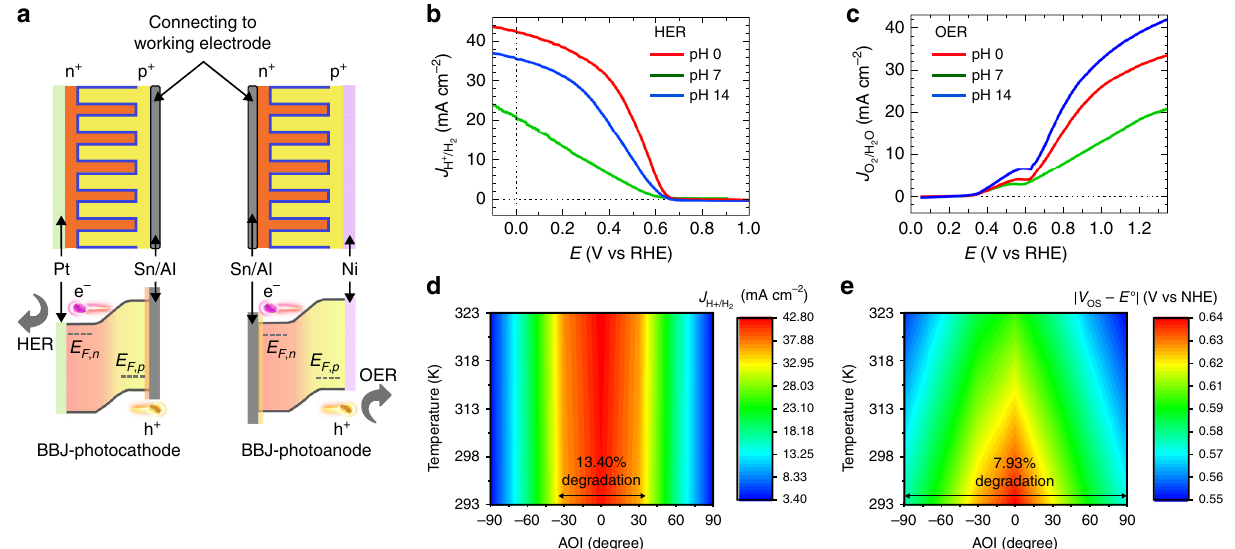
Fig. 2 Photoelectrochemical characteristics of a unit BBJ cell. a The schematic and band pro fi le of the BBJ – PEC cells. LSV curves under simulated AM 1.5 G illumination in acidic (red line), neutral (green line), and basic (blue line) electrolytes measured by a BBJ unit cell for b HER and c OER. The AOI and temperature dependent PEC characteristics of d J H þ = H and e | V OS − E 0 |. Note that NHE is the normal hydrogen electrode, V OS is the onset potential 2 measured at a hydration current of 1 mA cm − 2 , E 0 is the equilibrium water reduction potential, and J H þ = H is the saturation current density at E 0 for 2